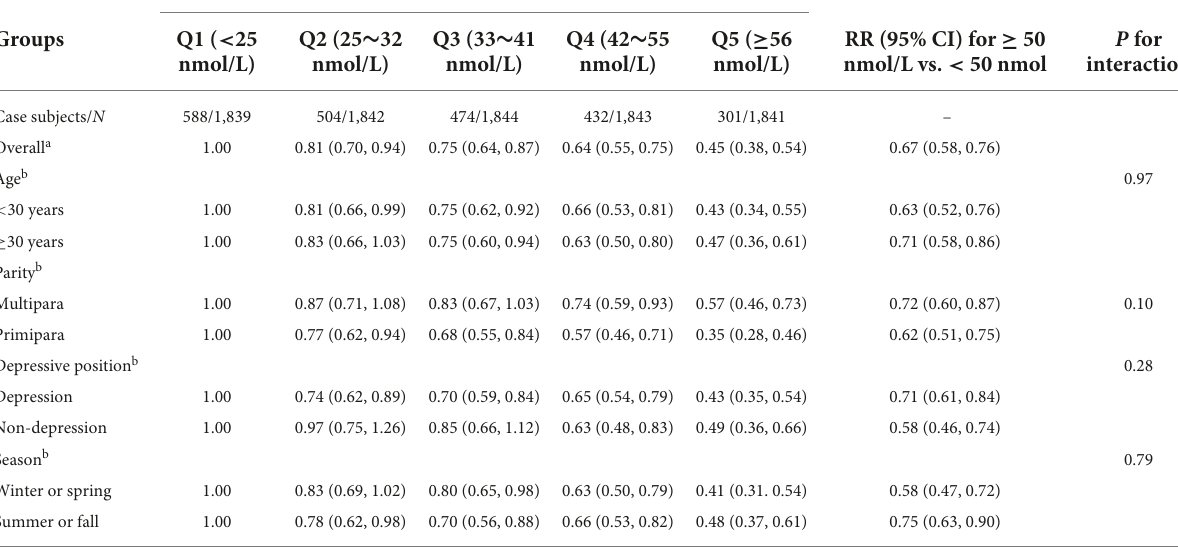
TABLE 2 Adjusted RRs and 95%CI for serum 25(OH)D with poor CVH, overall and by subgroup.